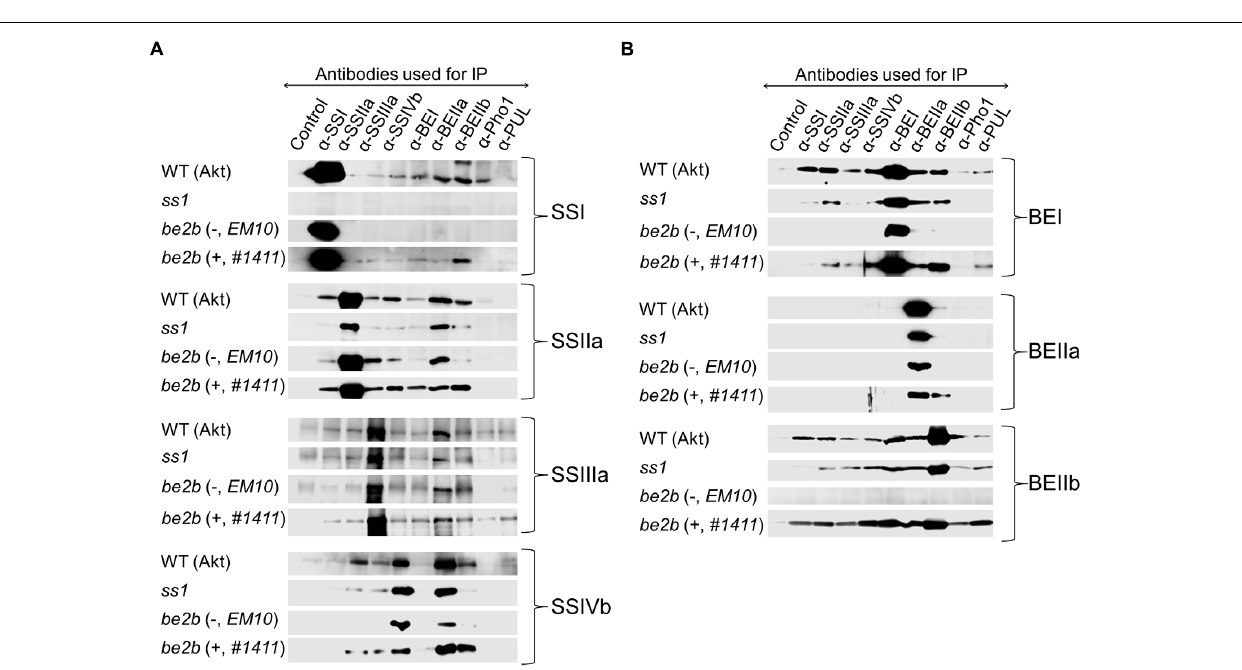
FIGURE 3 | Altered molecular weight distributions of starch biosynthetic enzymes from the be2b mutants lacking or producing inactive BEIIb protein, and their parental lines. Fractions 1–13 obtained after gel filtration chromatography of soluble proteins extracted from the developing seeds were analyzed by native-PAGE activity staining (A) . The fractions were denatured and used for western blotting with BEI, BEIIa, and BEIIb antibodies (B) , and western blotting with SSI, SSIIa, SSIIIa, and SSIVb antibodies (C) . Top, numbers (kDa) indicate molecular weight standards; (–), line EM10 , which lacks BEIIb protein; (+), line # 1411 , which produces inactive BEIIb protein. The parental wild-type (WT) of line EM10 is Kin and that of line # 1411 is Akt. The images are representative of three.